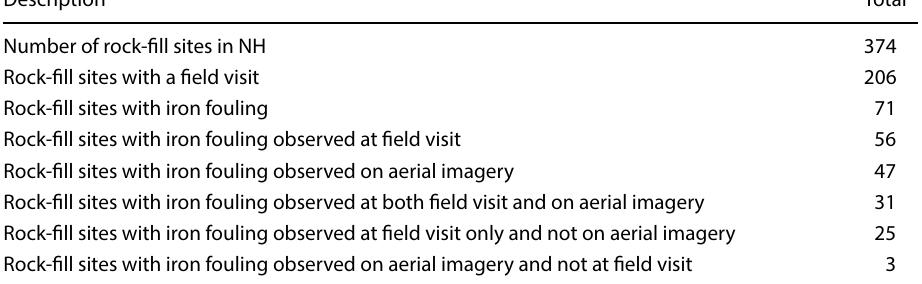
Table 1 Iron fouling observed on aerial imagery and at field visits at 374 rock-fill sites in NH